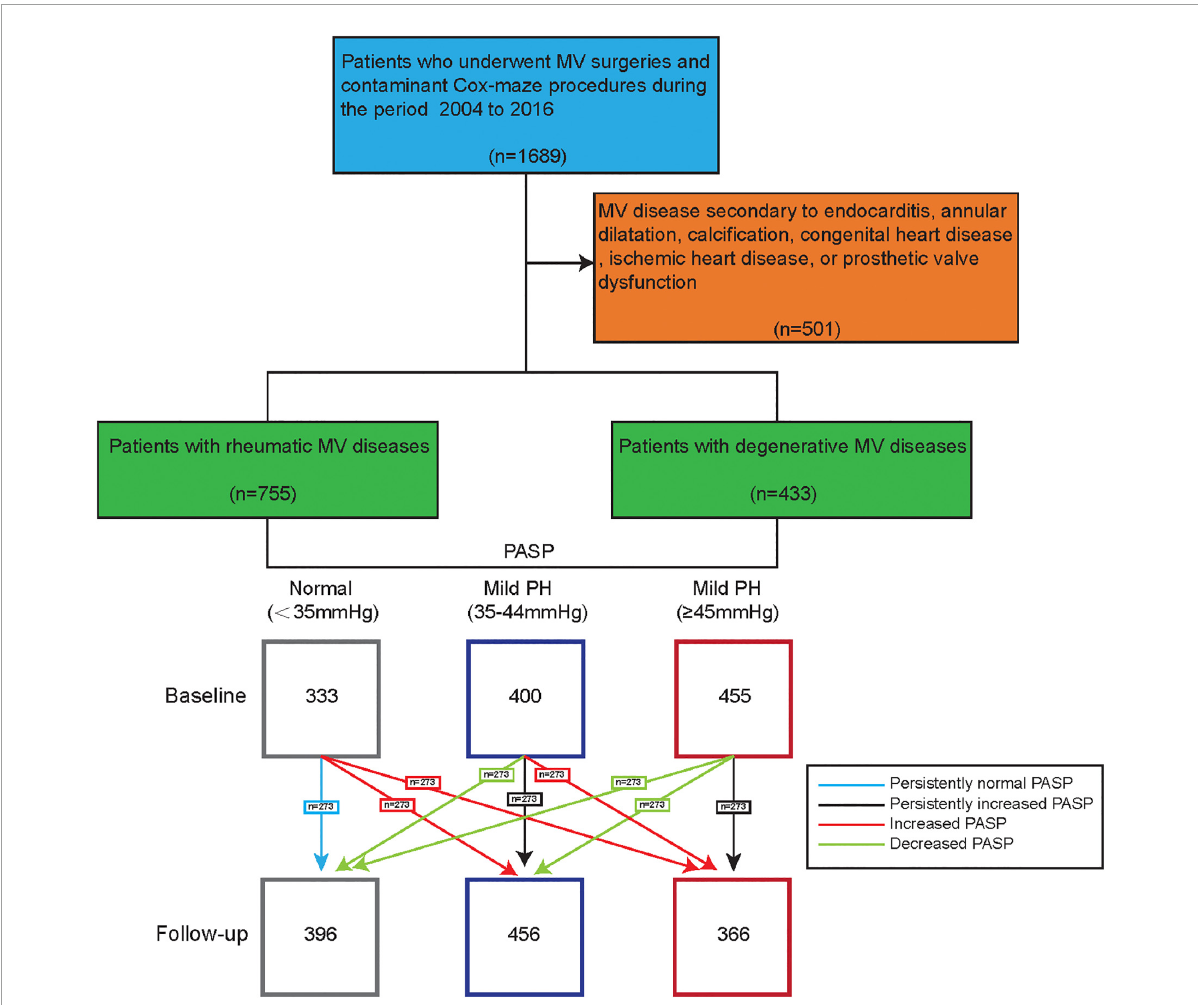
FIGURE1 Individual changes of pulmonary artery systolic pressure (PASP) from baseline to 5-year follow-up.